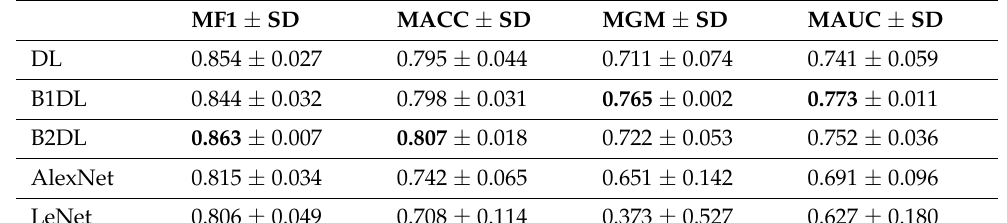
Table 4. Performance results of all prediction algorithms according to two-fold cross-validation on images pertaining to in vitro bovine embryos. The highest MF1, MACC, MGM, and MAUC values are indicated in bold. MF1 indicates the Mean F1. MACC indicates the mean accuracy. MGM indicates the mean G-Mean. MAUC indicates the mean area under the curve. SD indicates the standard deviation.